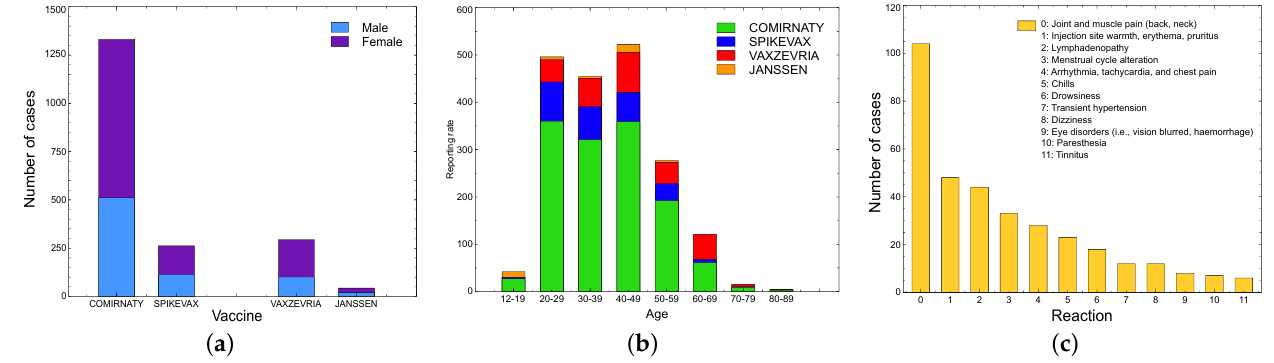
Figure 10. Main results of our pharmacovigilance activity: distribution of number of reported cases by sex ( a ), by age ( b ), and in “Other” category ( c